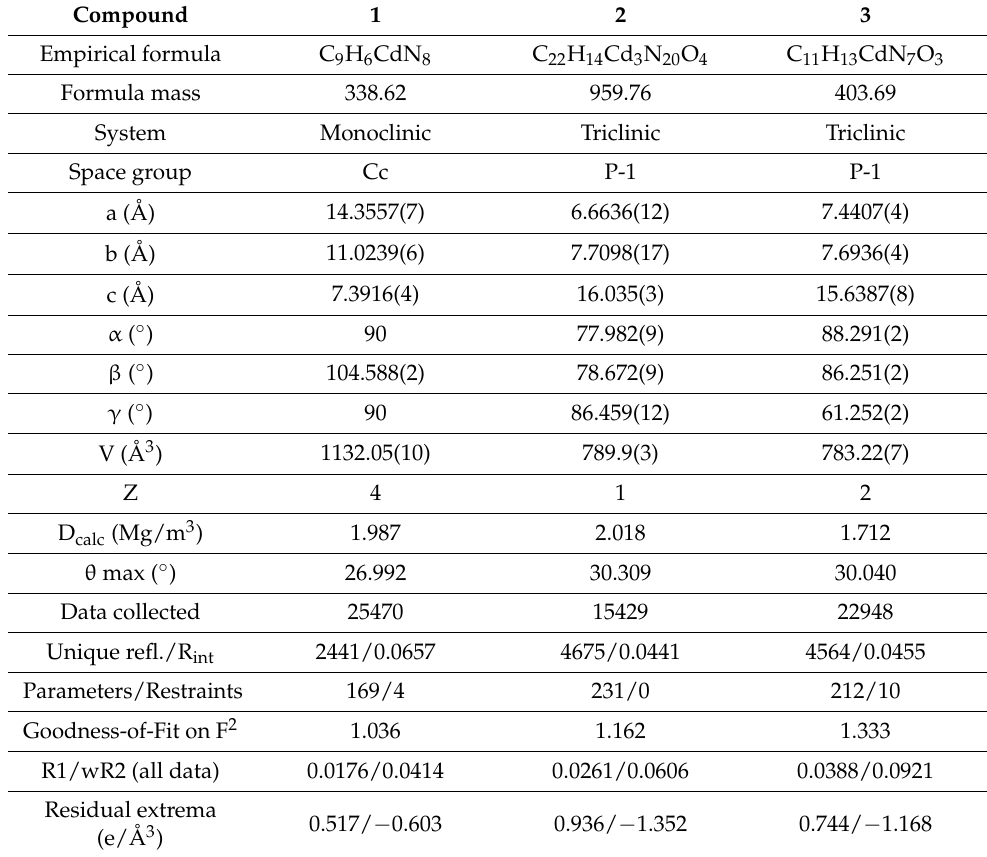
Table 1. Crystallographic data and processing parameters of 1 –